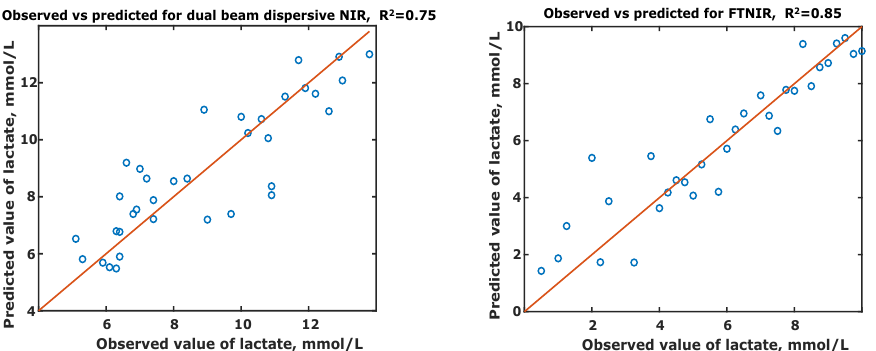
Figure 3. Observed (known) lactate concentration versus the Predicted concentrations of forty-one samples of lactate in whole blood. The correlation coefficient ( R 2 ) and the Root Mean Squared Error of Cross Validation (RMSECV) for each set are also shown. ( left ) The Coefficient of Determination ( R 2 ) and the Root Mean Squared Error of Cross Validation (RMSECV) for dual beam dispersive NIR data-set are 0.75 and 1.23 mmols/L respectively; ( right ) The Coefficient of Determination ( R 2 ) and the Root Mean Squared Error of Cross Validation (RMSECV) for FTNIR set are 0.85 and 1.02 mmols/L